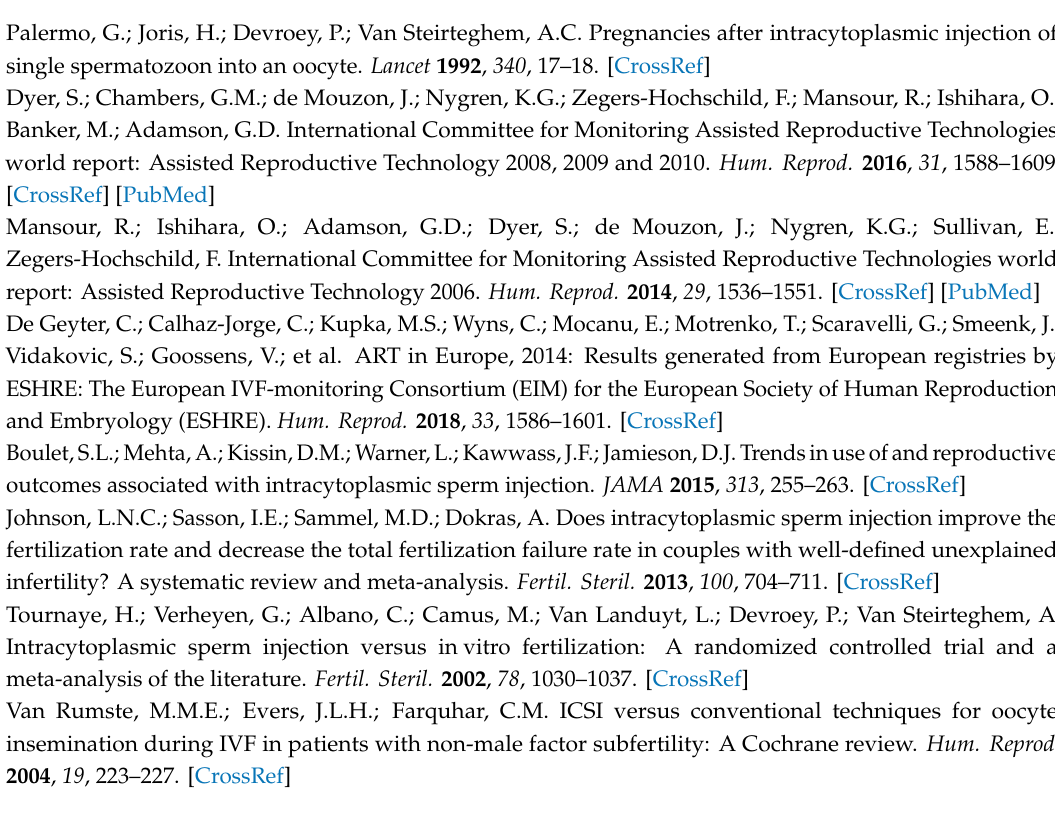
Table S1: Basal characteristics of the patients with no previous treatments in the two study